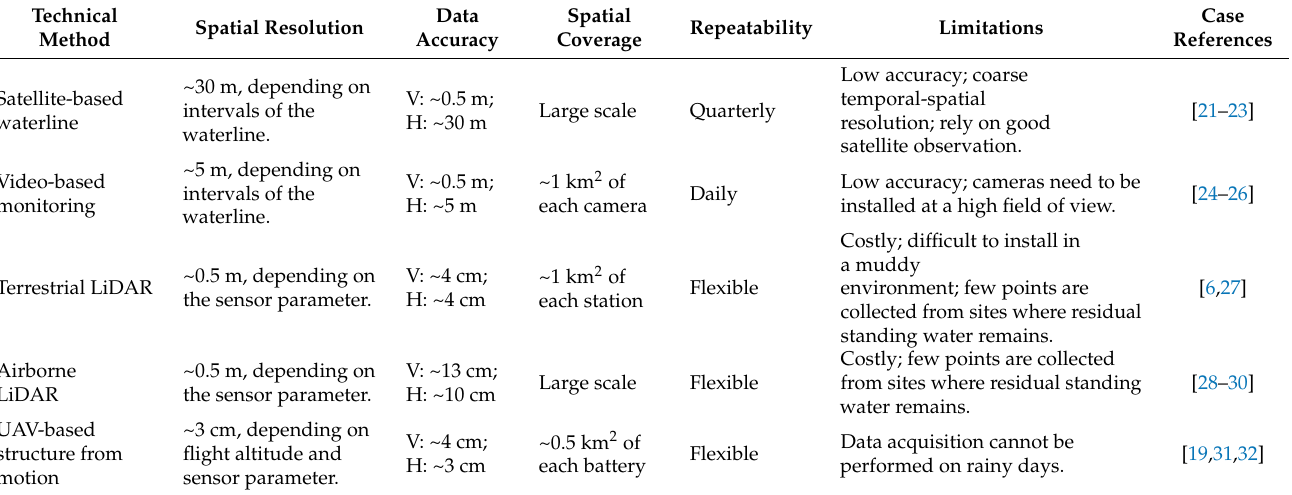
Table 1. Comparison of different topographic mapping methods in intertidal mudflats. V—vertical;